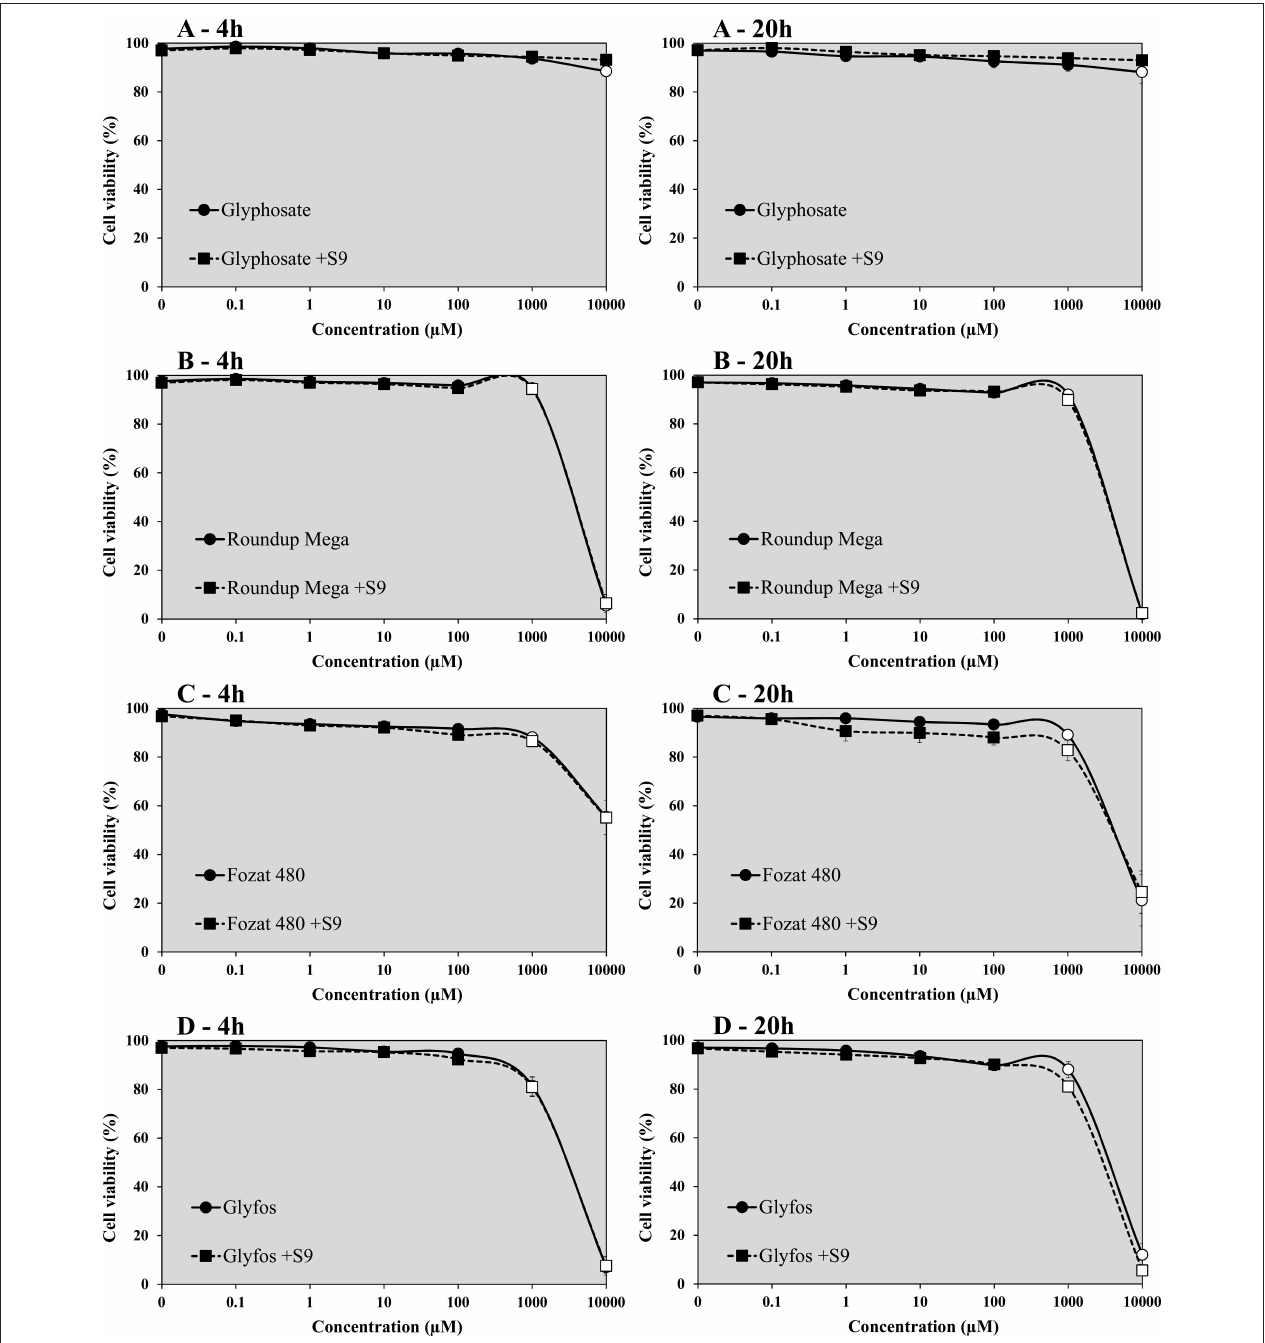
FIGURE 1 | Effect of 4- and 20-h exposure to increasing concentrations of glyphosate (A) , Roundup Mega (B) , Fozat 480 (C) , and Glyfos (D) on cell viability in the absence and presence ( + S9) of metabolic activation system detected by fluorescent co-labeling. The data points indicate the means ± standard error of the mean (SEM) of three repeated experiments. Statistically significant decrease of cell viability, indicated by empty data points, was determined by comparing the values induced by various doses of glyphosate or GBHs to the background level of untreated cells by ANOVA with Dunnett’s post hoc test.